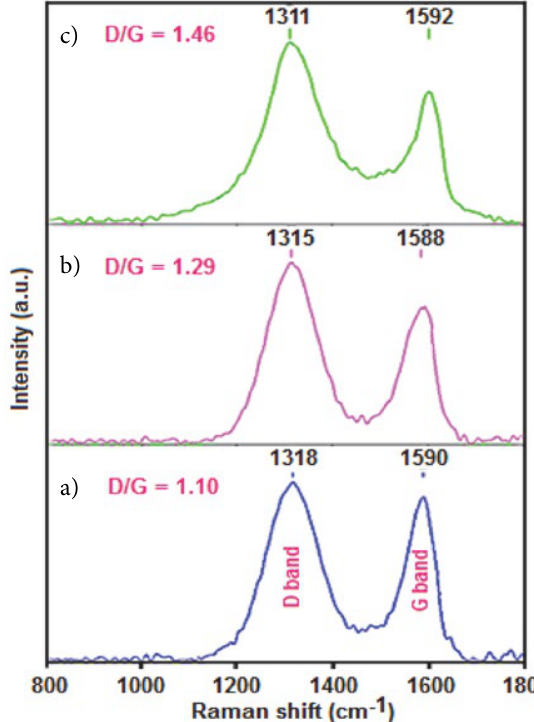
Figure 4. Raman spectra of (a) GO, (b) Fe Fe